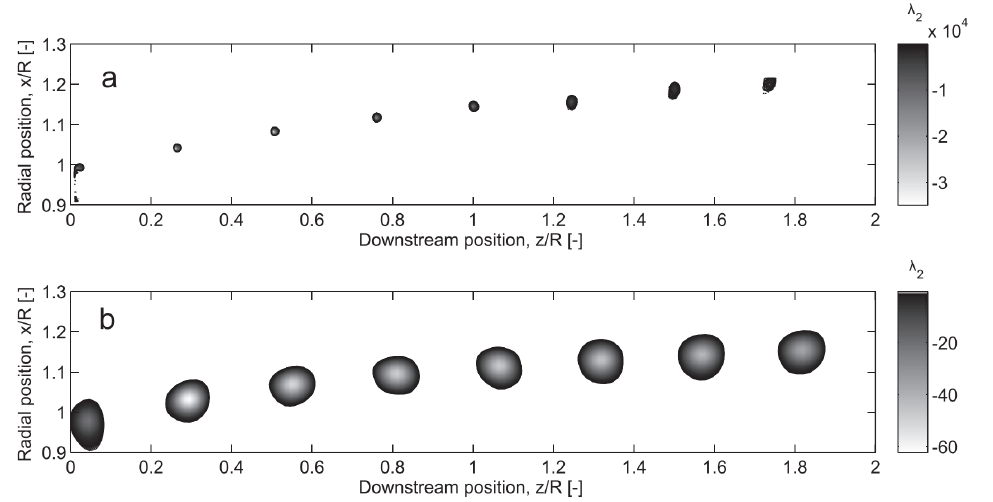
Figure 10. Visualization of the tip vortex cores as a function of downstream distance for TSR = 6.2 for ( a ) the experimental measurement of the MEXICO project and ( b ) the AL model simulation with the grid spacing of h = R /122 near the blade tip with Gaussian distribution of force. All vortices are identified with the λ 2 criterion. Reprinted with permission from Nilsson et al. [106]. 2014, John Wiley and Sons.